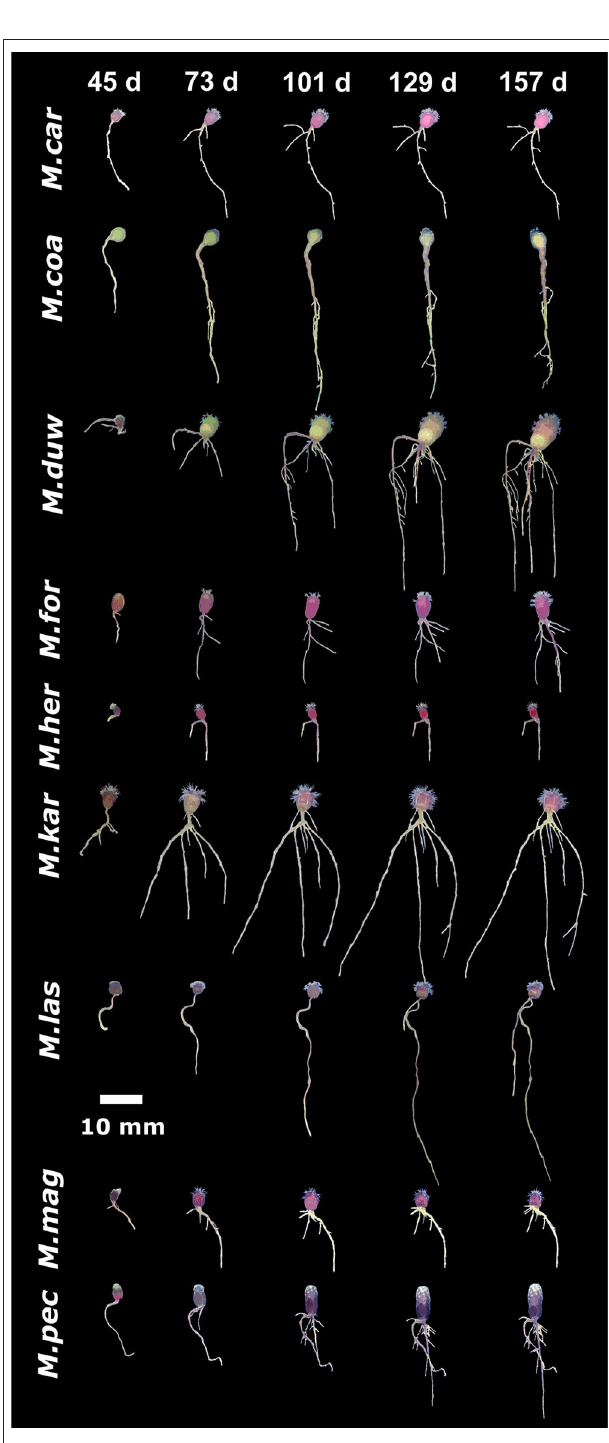
FIGURE 5 | Growth dynamics in Mammillaria species from series other than Supertextae , over five developmental stages (45, 73, 101, 129, and 157 days after germination). For simplicity, acronyms of these species were created as follow: M. car , M. carnea ; M. coa , M. coahuilensis ; M. duw , M. duwei ; M. for , M formosa ; M. her , M. hernandezi ; M. kar , M. karwinskiana ; M. las , M. lasiacantha ; M. mag , M. magnimama ; M. pec , M. pectinifera